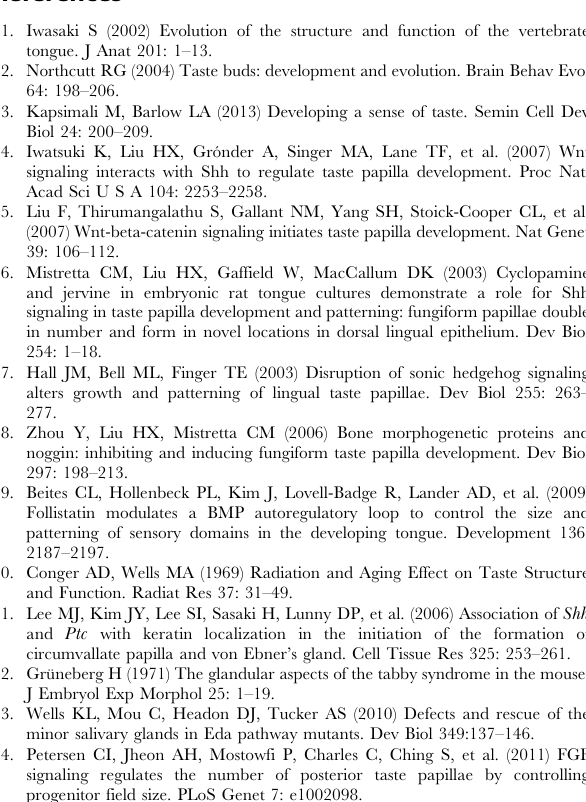
(arrowheads) at embryonic stages. ( D,E ) Pax9 immunostaining of CVP (D) and FOP (E) in adult K14 Cre ;Pax9 fl/fl mice. Although little (CVP) or no (FOP) Pax9 protein is detectable, the morphology of the taste papillae and taste buds appears normal. Inset shows Pax9 staining in one of the minor salivary glands as a positive control for epithelial cells in which K14 Cre is not active. Figure S4 Expression of K6 (A,B) and K5 (C,D) in the dorsal tongue epithelium of adult mice. K6 expression was upregulated in the interpapillary epithelium but not in the fungiform papilla (FUP) of K14 Cre ;Pax9 fl/fl mice (arrowheads in B), In contrast, K5 was normally expressed in the dorsal tongue epithelium of K14 Cre ;Pax9 fl/fl mice (D). Scale bars: 50 m m. Figure S5 Similar to Prox1 , Ascl1 is expressed in the CVP trench of wild type (arrowhead in A) but not of Pax9 -deficient mice (B) at E18.5. Scale bars: 50 m m. Figure S6 In addition to localized domains in the trenches, Prox1 and K8 are also expressed in the apical domain of the CVP at E18.5 (arrowheads in (A) and (B)). (C) Expression of K8 in the apical domain is also seen in the Pax9 -deficient CVP. Scale bars: 50 m m. Figure S7 Histological analysis of cultured embryonic tongue explants. Beads are indicated by asterisks. (A) In the presence of Shh protein, trench formation could not be rescued in the Pax9- deficient explant and a large CVP dome developed instead. (B) An enlarged CVP did not form in mutant explants after treatment